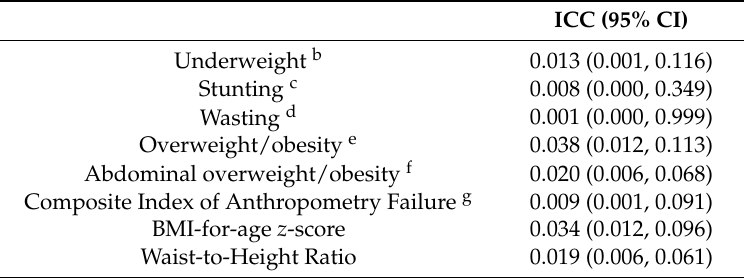
Table 10. Estimates of the intracluster correlation coefficient (ICC) for each outcome measure a